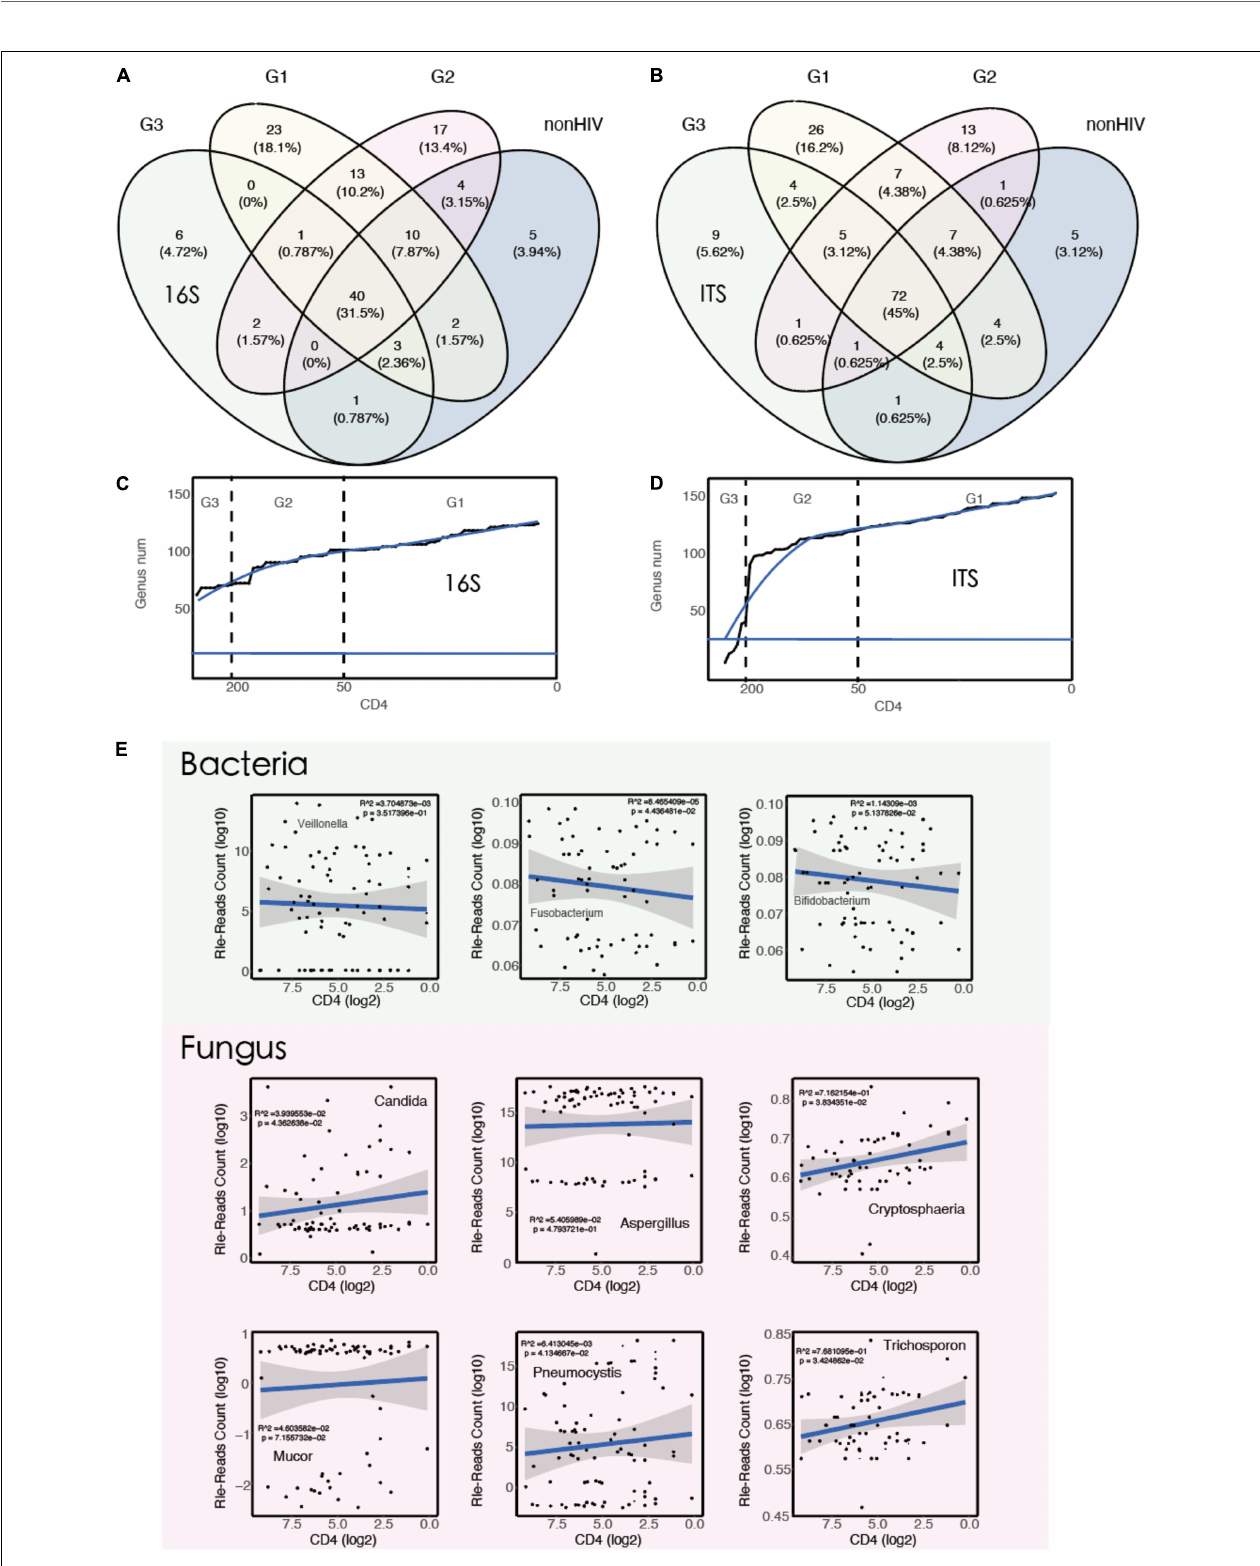
FIGURE 2 | The types of microorganisms in the BALF of HIV-positive individuals increase with decreasing CD4 counts. (A) A Venn diagram showing bacterial genus distribution of 16S rRNA for each group (G1 vs. G2 vs. G3 vs. non-HIV). (B) A Venn diagram showing fungal genus distribution of ITS rRNA for each group (G1 vs. G2 vs. G3 vs. non-HIV). (C) Smooth line diagram of the change in the bacterial count target. (D) Smooth line diagram of the change in the fungal count target. (E) Linear model used to describe the relationship between species numbers and CD4 counts.